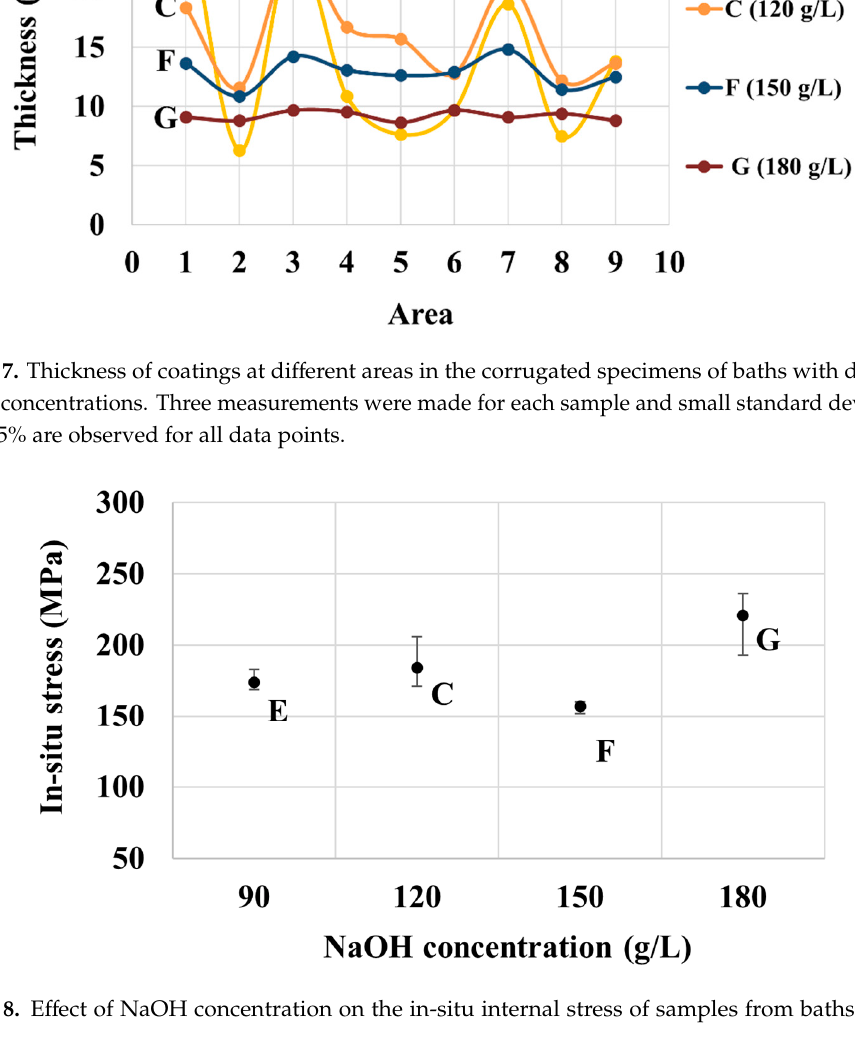
Figure 7. Thickness of coatings at different areas in the corrugated specimens of baths with different NaOH concentrations. Three measurements were made for each sample and small standard deviations below 5% are observed for all data points.